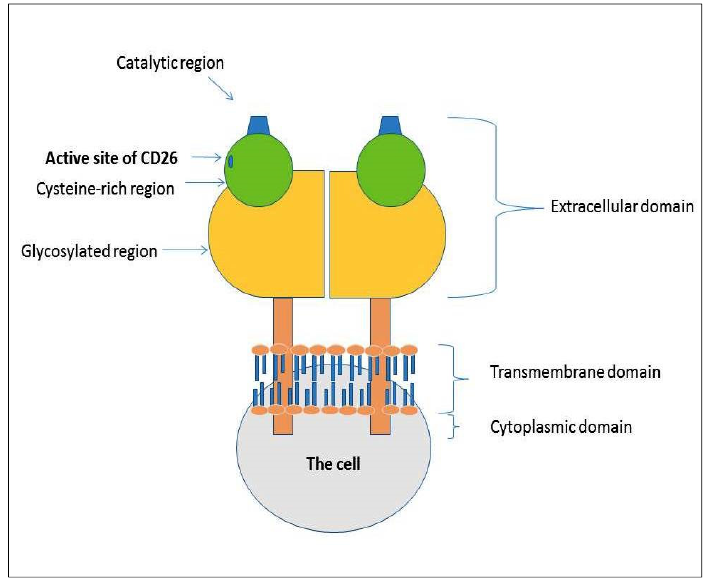
Figure 1. Structure of CD26. It consists of two subunits containing three domains: catalytic region, a transmembrane region, and a large extracellular region.